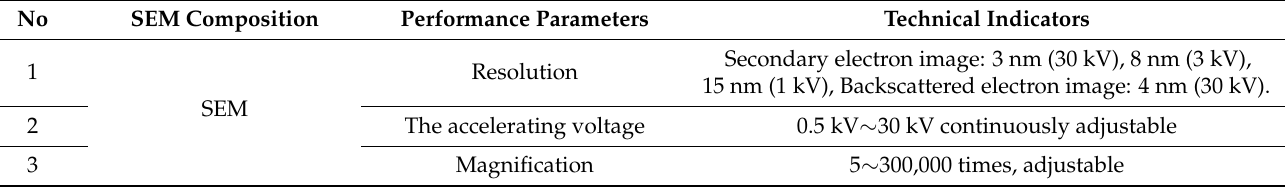
Table 1. Main parameters of the equipment.